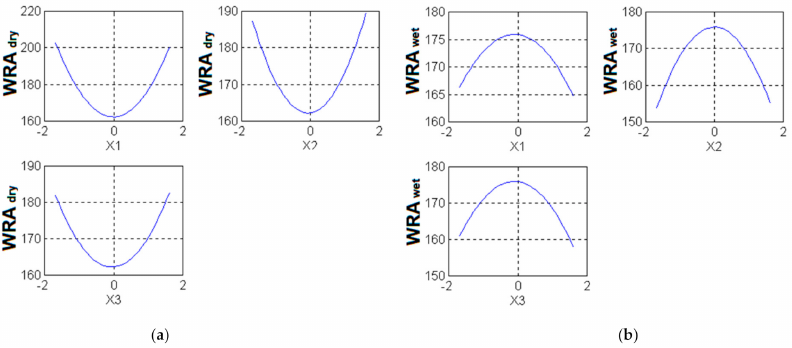
Figure 7. The variations of wrinkle recovery angle (WRA) function of the independent variables X 1 , X 2 and X 3 .: ( a ) WRA dry ; ( b ) WRA wet